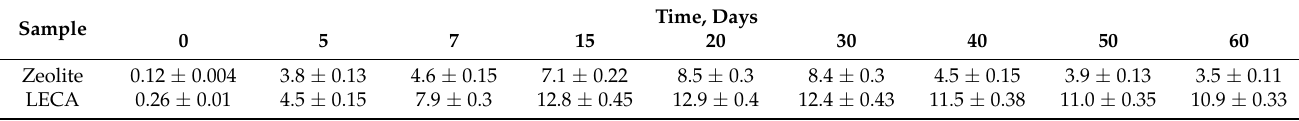
Table 2. Kinetics of total organic carbon accumulation on the studied materials (mg/g) *.